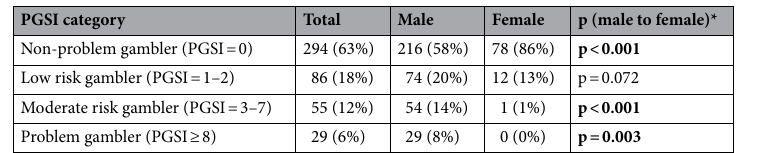
Table 2. Problem Gambling Severity Index amongst current gamblers. *Values compared using a chi squared test. Significant values are in bold.